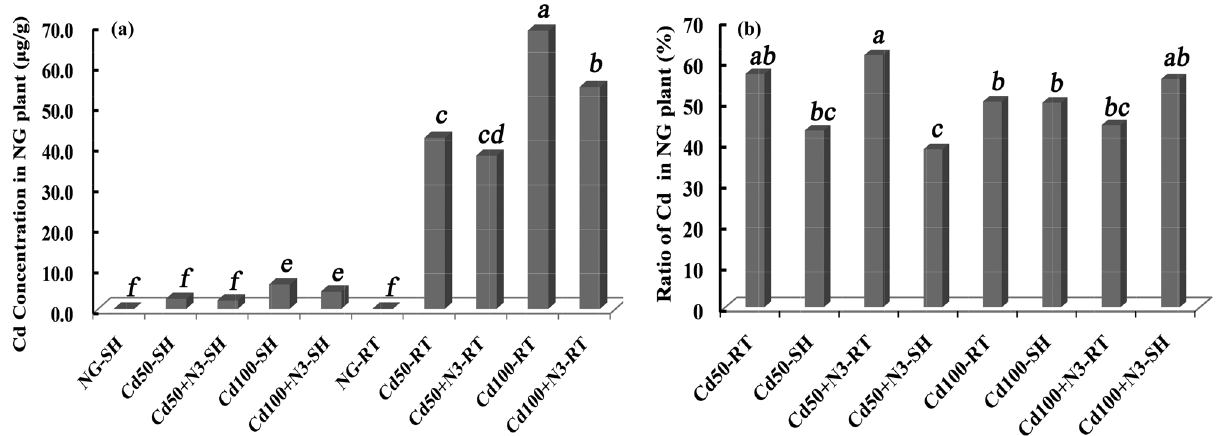
Figure 4: Concentrations of Cd in the shoot and root tissues of nongrafted plants. Signi fi cant di ff erences tested according to Duncan ’ s test at p < 0.01. ( a ) Cd concentration and ( b ) ratio of Cd in nongrafted plants. Values are the means ± standard deviations of three replicates. SH, shoot; RT,